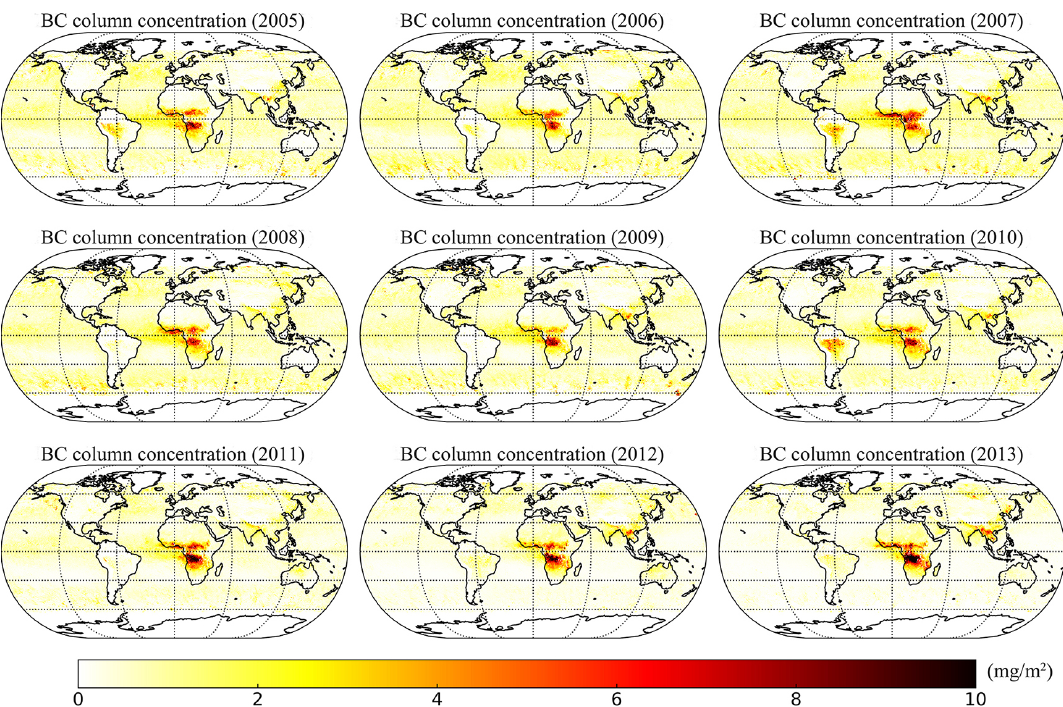
Figure 3. Yearly mean of BC column mass concentration (mgm − 2 ) derived from POLDER-3 observations using the GRASP/Component approach for the period from March 2005 to October 2013.